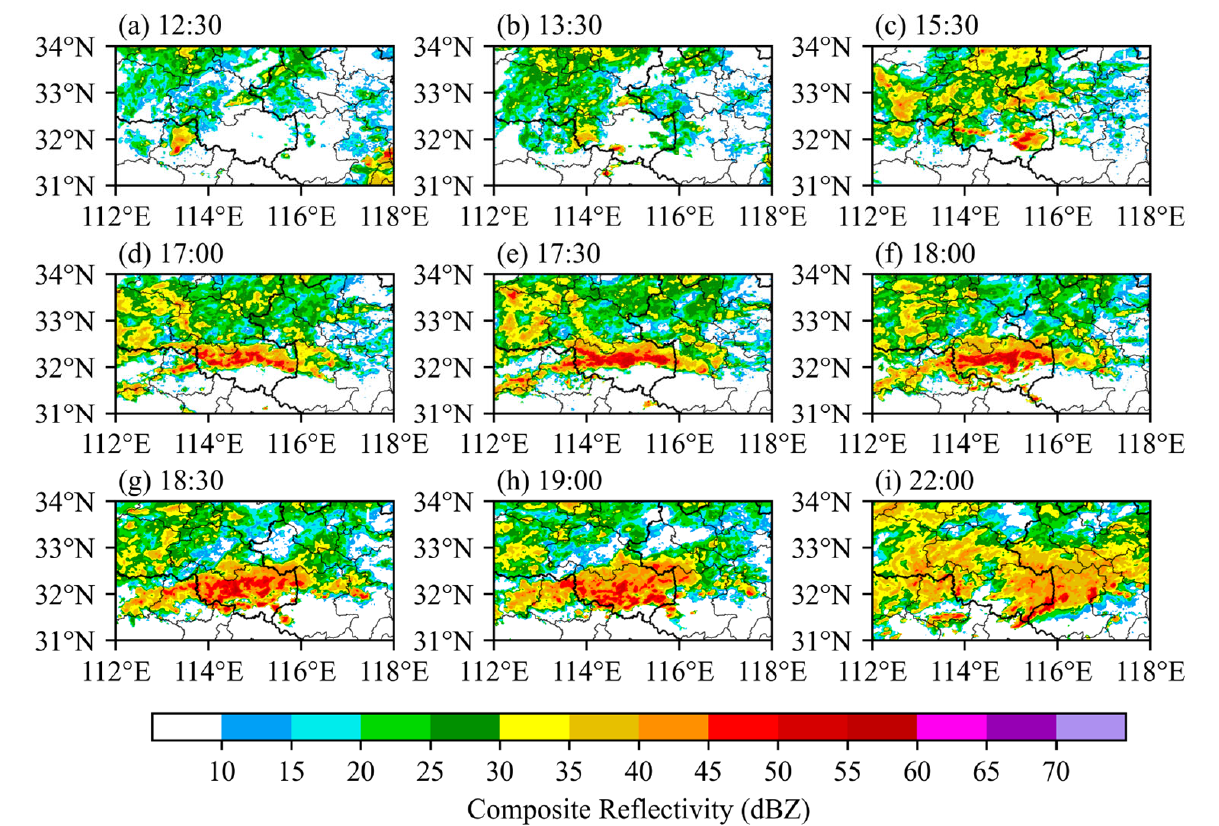
Figure 3. The mosaics of radar composite reflectivity (shaded, units: dBZ) at ( a ) 1230, ( b ) 1330, ( c) 1530, ( d ) 1700, ( e) 1730, ( f ) 1800, ( g ) 1830, ( h ) 1900, ( i )2200 UTC 11 July 2014.